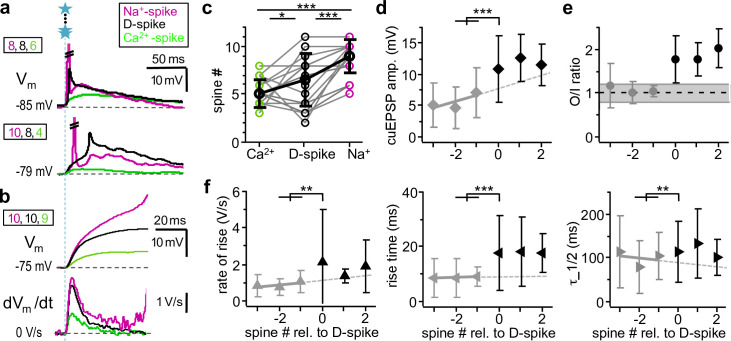
D-spikes in approximately two thirds of granule cells: Spikelets and/or increased rate of rise associated with onset of supralinearity in O/I plot.a: Examples of somatic spikelets recorded from 2 different cells at different numbers of coactivated spines. Green traces and spine numbers: Ca2+-spike threshold. Black traces and numbers: Na+-spikelets. Magenta traces and numbers: Full-blown global Na+-spikes, truncated (Na+-spike: short for global Na+-spike, also in c). b: Example cuEPSP Vm recording in rising phase (top) and first derivative (bottom). Colors as in a, black here: D-spike, indicated by increase in rate of rise. c: Comparison of spine numbers sufficient to elicit Ca2+-spike, D-spike and global Na+-spike in the same granule cell (n = 18 cells; F(2,53) = 20.75, p < 0.001, Ca2+-spike: 5.1 ± 1.4, D-spike: 6.5 ± 2.7, global Na+-spike: 8.9 ± 1.7 Holm–Sidak post hoc: Ca2+-spike versus D-spike: p = 0.027, Ca2+-spike versus global Na+-spike: p < 0.001, D-spike versus global Na+-spike: p < 0.001). d: Mean somatic cuEPSP amplitudes with spine numbers aligned relative to D-spike threshold for granule cells with supralinear sO/Is (n = 18; x-axis as in panel below). Difference between [−2/−1] and [0] highly significantly different from extrapolated linear fit (p < 0.001; Wilcoxon test, see Materials and methods, see S2B Fig for data points from individual experiments). Gray symbols: subthreshold D-spike, black symbols: suprathreshold D-spike, dashed line: linear fit of subthreshold mean amplitudes, also for e, f. e: Mean O/I ratios aligned relative to D-spike (x-axis as in panel below). Increase from 1.03 ± 0.13 to 1.77 ± 0.54, not tested, because the onset of supralinear O/I ratios was the criterion for the selection of cells and the setting of the D-spike threshold. f: Kinetics of cuEPSPs (n = 18 cells): Highly significant increases beyond extrapolated linear fits at D-spike threshold for rate of rise (left, p = 0.002, n = 18), rise time (middle, p < 0.001, n = 18) and half duration τ_1/2 (right, p = 0.009, n = 16). See S2B Fig for data points from individual experiments. Amp, amplitude; D-spike, dendritic Na+-spike; O/I, output/input; rel, relative; cuEPSP, compound uncaging-evoked excitatory postsynaptic potential.